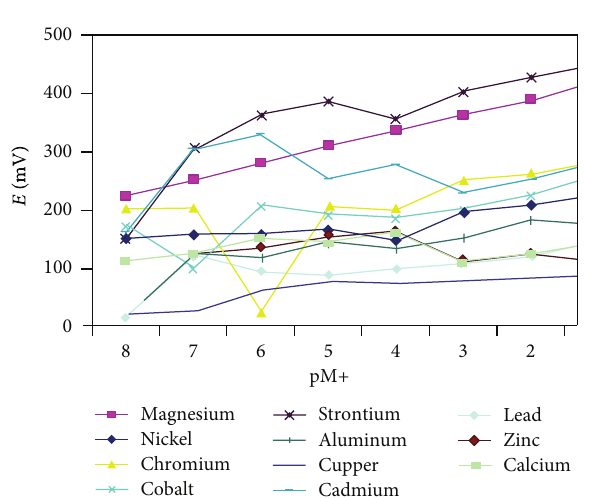
F 2: Potential response of various ion Selective electrodes based on MPS.